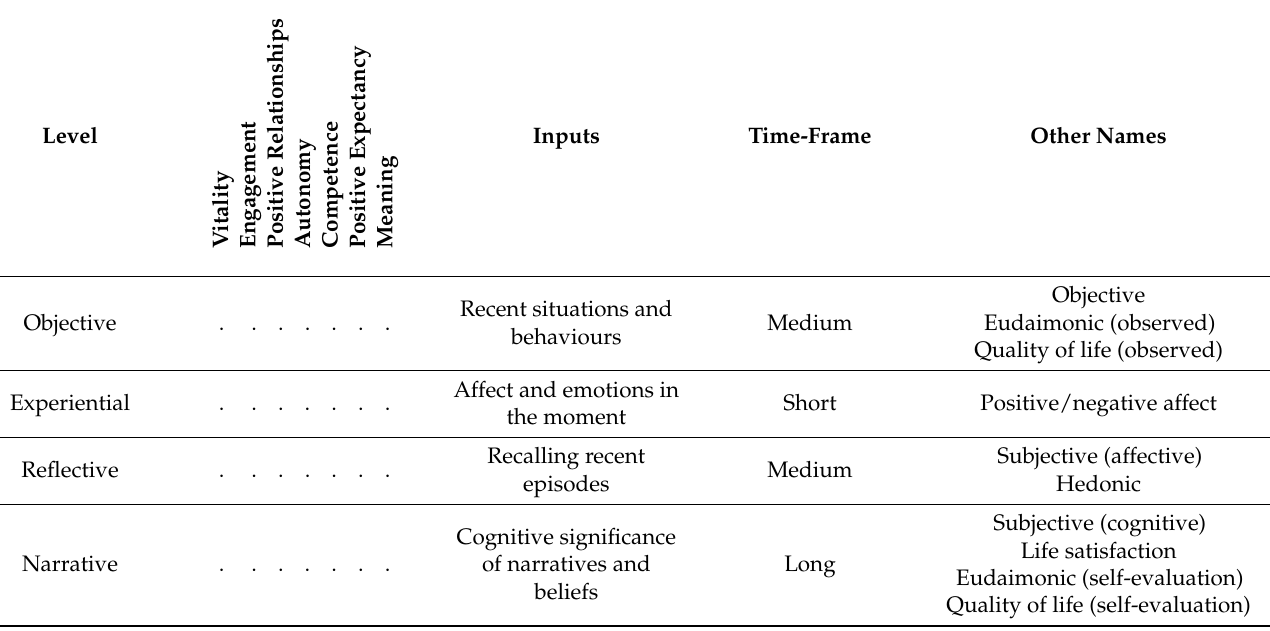
Table 1. Four levels of wellbeing against various wellbeing aspects. Each aspect applies to each level in different